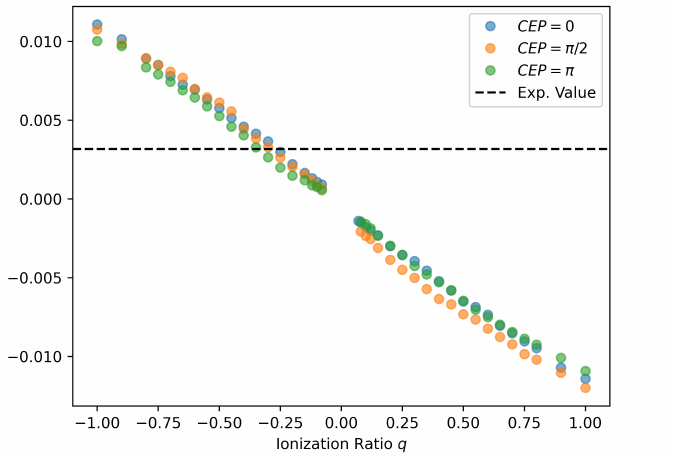
Figure 3. Ionization ratio q (Equation (12)) vs. average offset momentum a (Equation (13)) for various values of carrier envelope phase. The experimental offset momentum determined in reference [14] is indicated by the dashed line. It appears that regardless of the CEP, the ratio of downfield to upfield ionization remains roughly